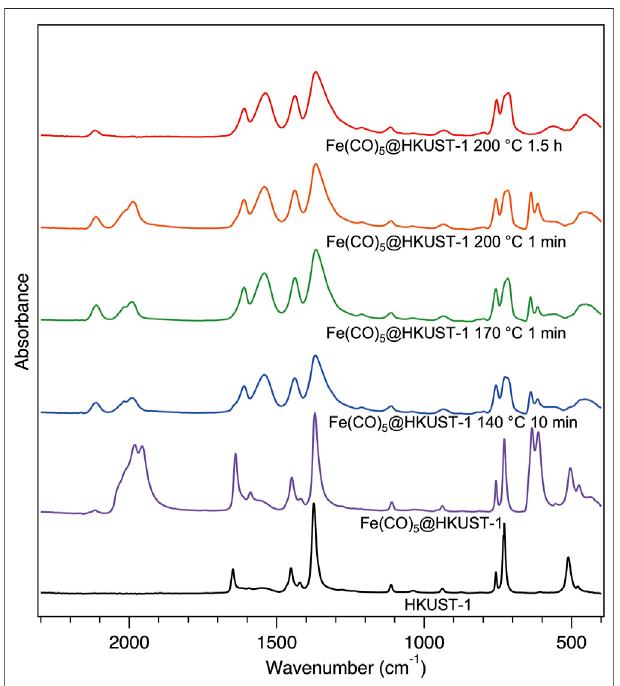
FIGURE 4 | Infrared spectra for activated HKUST-1 (black), Fe(CO) 5 @ HKUST-1 (purple), and the thermal decomposition products of Fe(CO) 5 @ HKUST-1 at different conditions: 140 ° C-10 min (blue), 170 ° C-1 min (green), 200 ° C-1 min (orange), and 200 ° C-1.5 h (red). All samples were measured inside a glovebox.